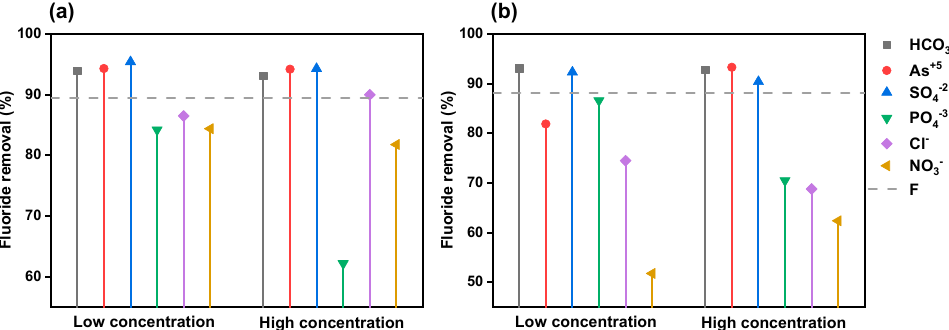
Figure 8. Fluoride removal in the presence of other ions ( a ), BOP-Zr ( b ) BAP-Zr, with F initial = 4 mg/L, Contact time 24 h and pH 3.5 ± 0.2.